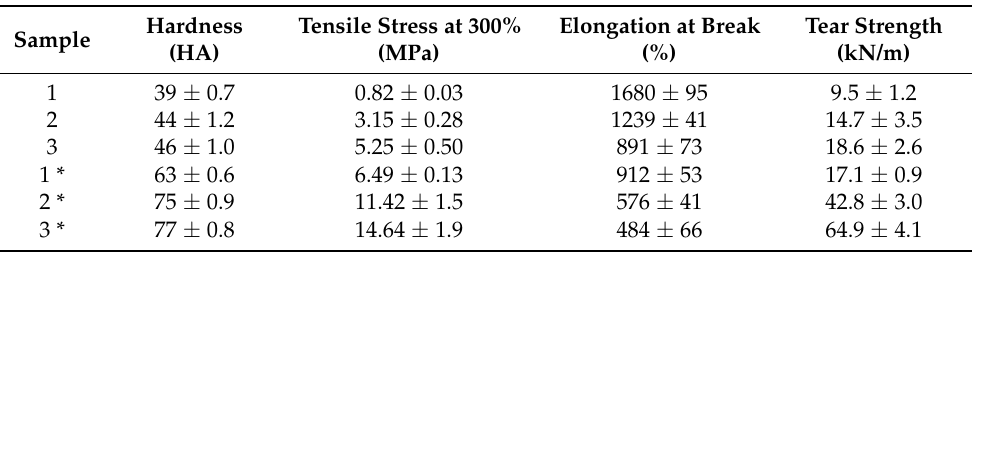
Table 5. Mechanical properties of fiber/NR composites with different